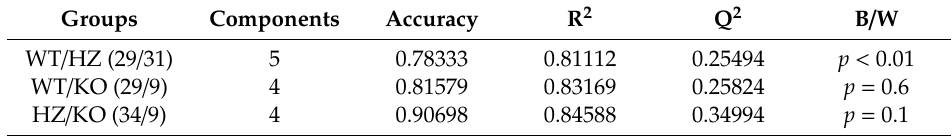
Table 1. PLS-DA parameters for the comparison between di ff erent groups.